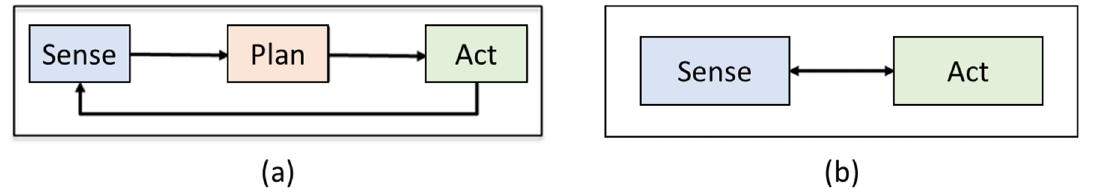
Figure 3. Robotic control approaches: ( a ) deliberative approach; and ( b ) reactive approach [31].